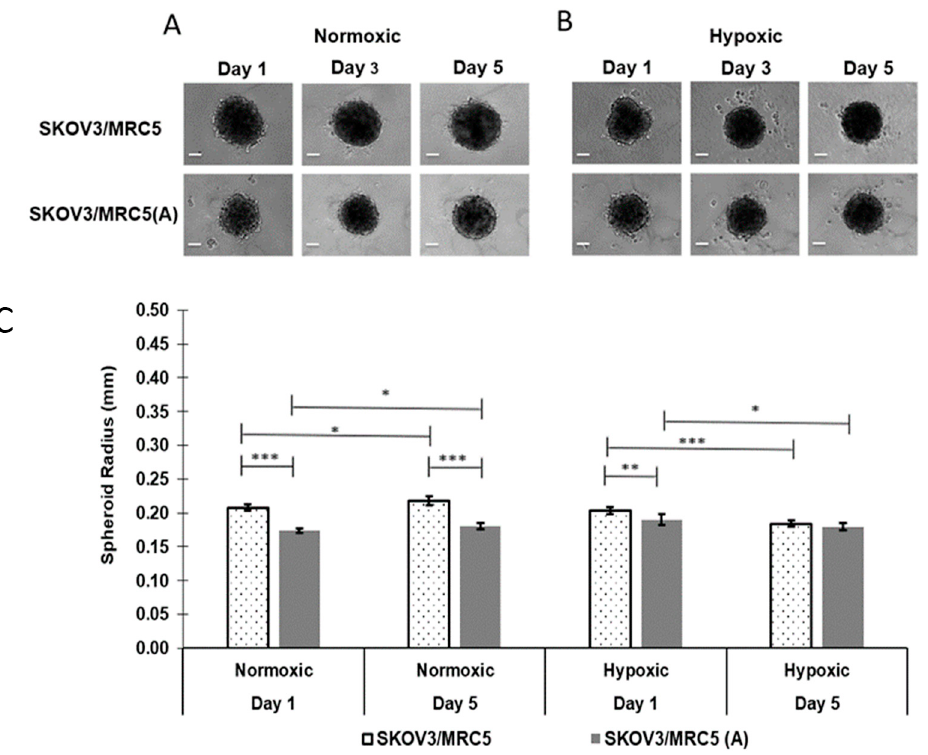
Figure 2. Non-PMX spheroid growth patterns as a function of activation and oxygenation over 5 days measured as maximum cross-sectional radius. Representative phase-contrast images of ( A ) normoxic and ( B ) hypoxic non-PMX nonactivated (SKOV-3/MRC-5) and activated (SKOV-3/MRC-5(A)) spheroid growth. ( C ) While spheroids increased in size in normoxia, they decreased in size in hypoxia, with stromal activation overall yielding smaller volumes. Data were deemed statistically significant using one-way ANOVA (* p ≤ 0.05, ** p ≤ 0.005, *** p ≤ 0.0005). Error bars represent the mean ± standard deviation. Scale bars represent 100 μ m.